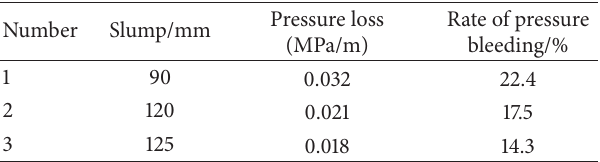
Figure11:Theperformanceofwet-mixshotcretewithvariousGSAE concentration. Table 4: The pumpability comparison of different wet-mix shotcretes.